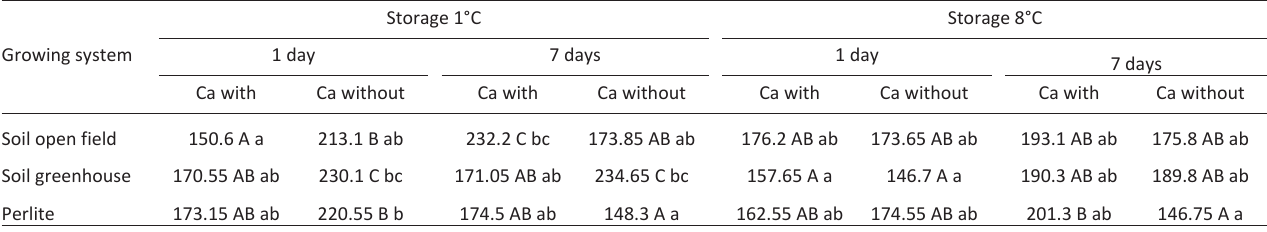
Table 3 - Antioxidant capacity (mg of ascorbic acid 100 g -1 of fresh weight) at 1, 3 and 7 days of postharvest of strawberries grown in dif- ferent growing systems, calcium lactate treatment and two storage temperatures